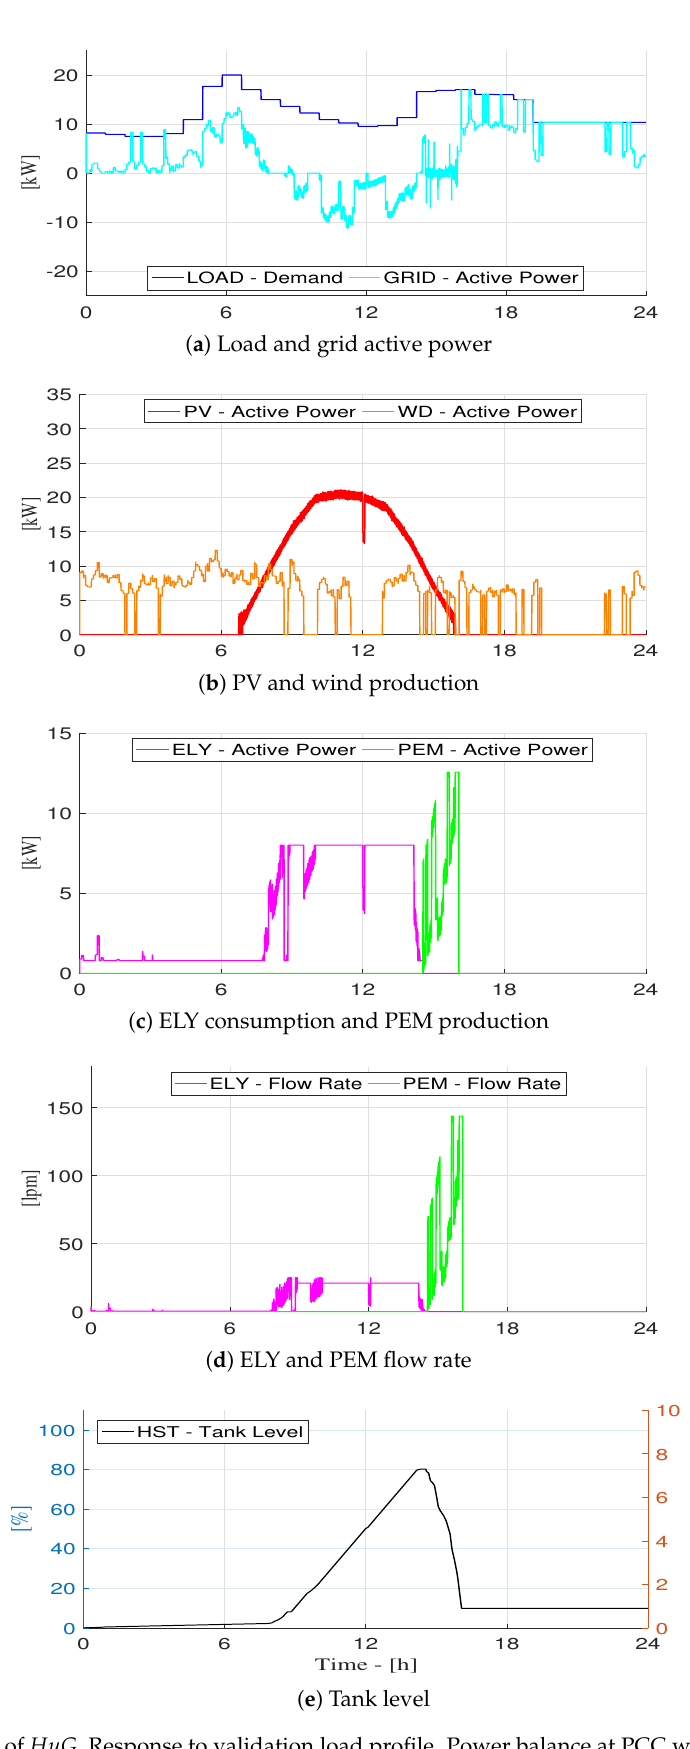
Figure 12. Global model of H µ G . Response to validation load profile. Power balance at PCC with active power in